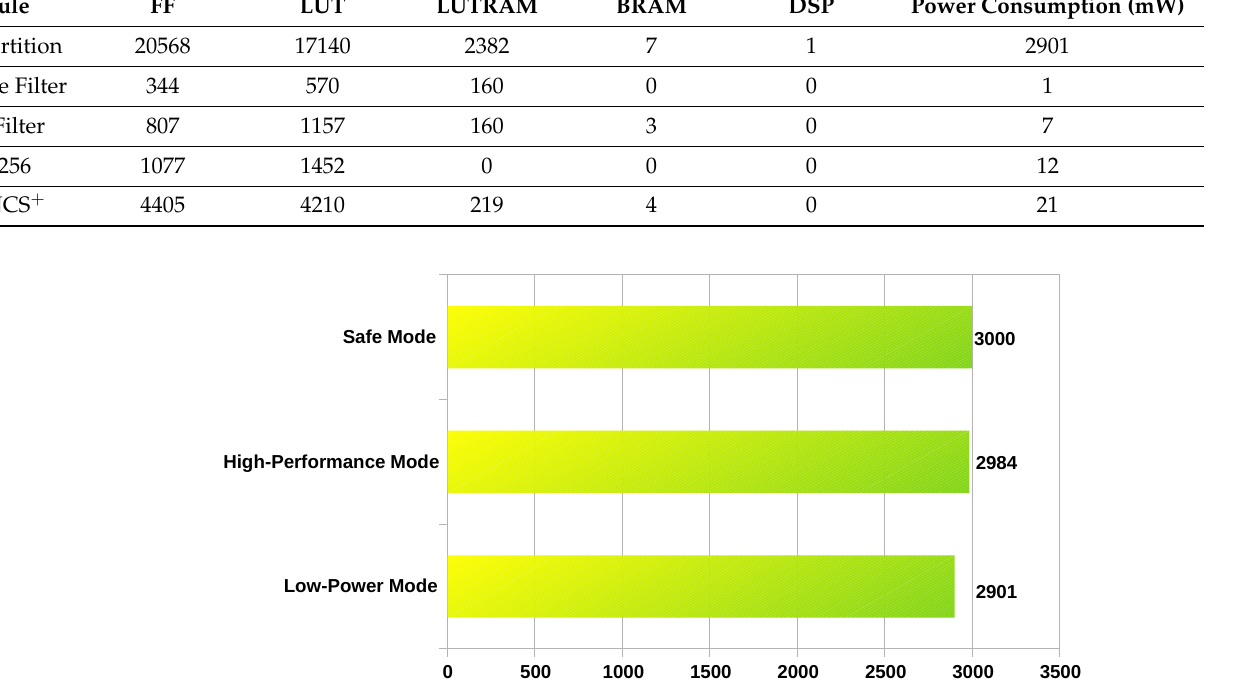
Figure 8. Estimated power consumption for the platform execution modes